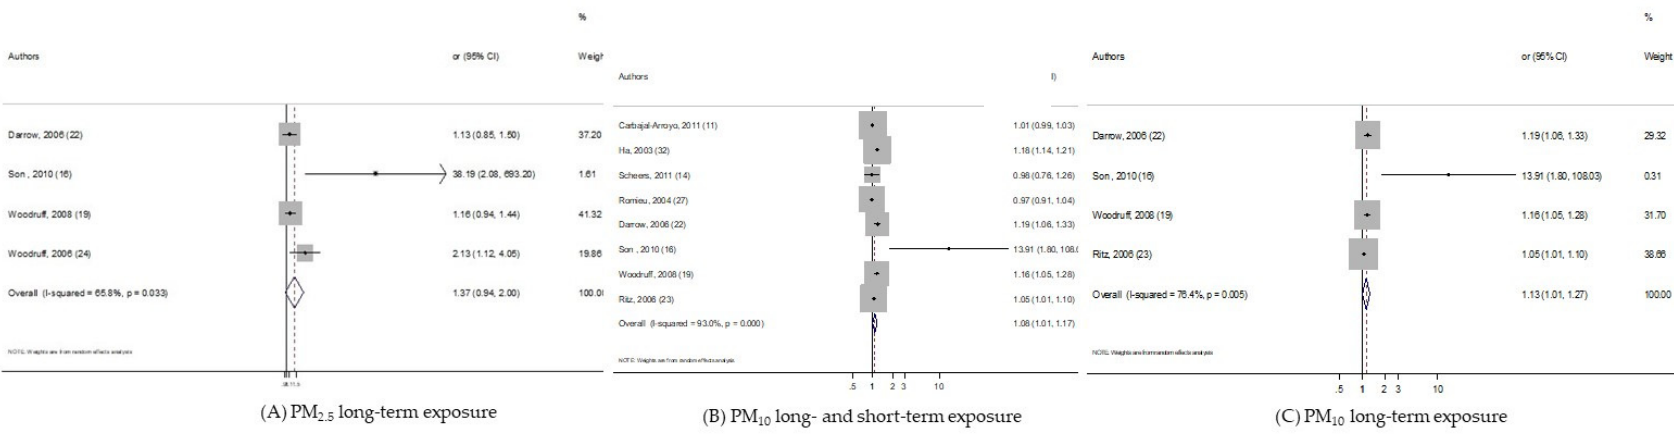
Figure 3. Forest plots for combinations of post-neonatal death Respiratory-causes and pollutant. Legend Figure 3: The size of each square represents the weight that contributes to the combined effect, respectively for: ( A ) Long-term PM 2.5 ; ( B ) long- and short-term PM 10 ; ( C ) long-term PM 10 .